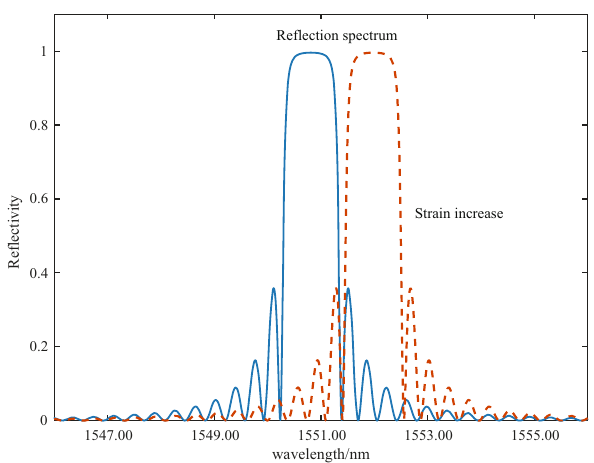
Figure 4: Center wavelength shift characteristics of the re fl ected